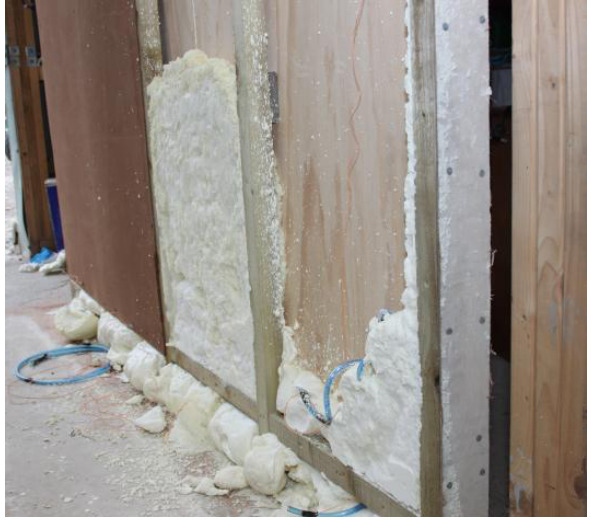
Figure 7. Observation of the outcomes